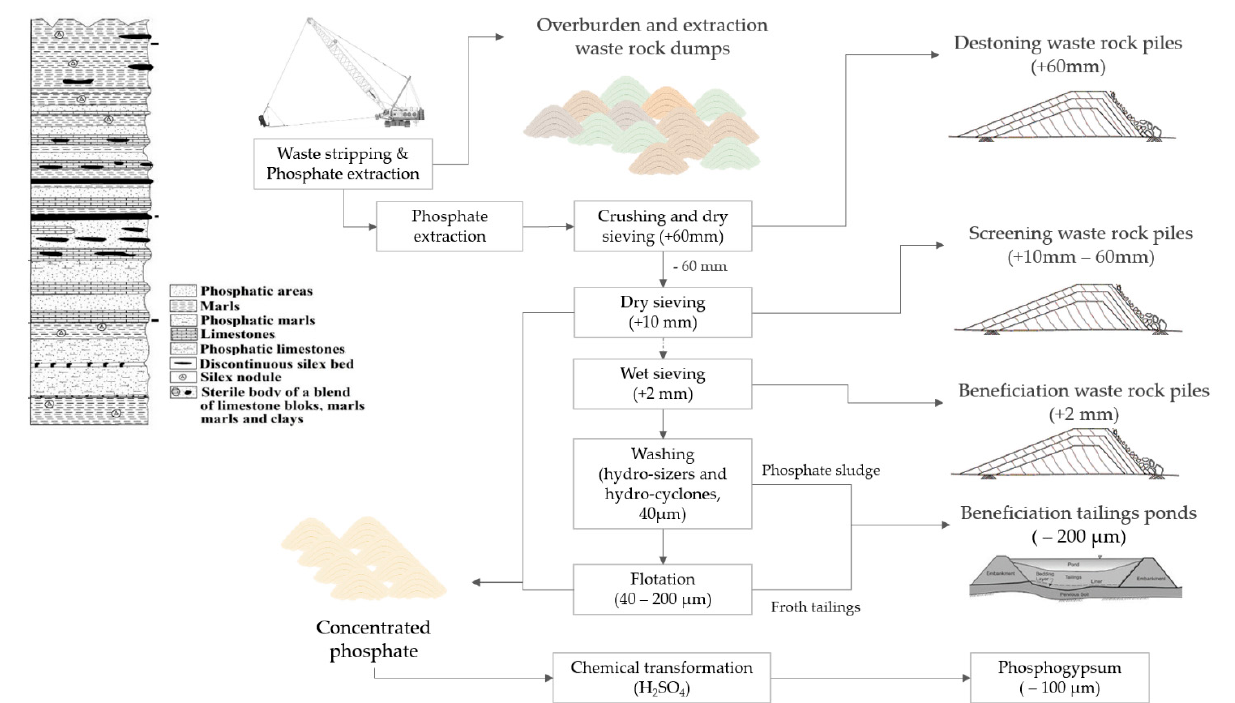
Figure 4. A general flowsheet of the different waste streams from the mining, beneficiation, and transformation of sedimentary phosphate ore.